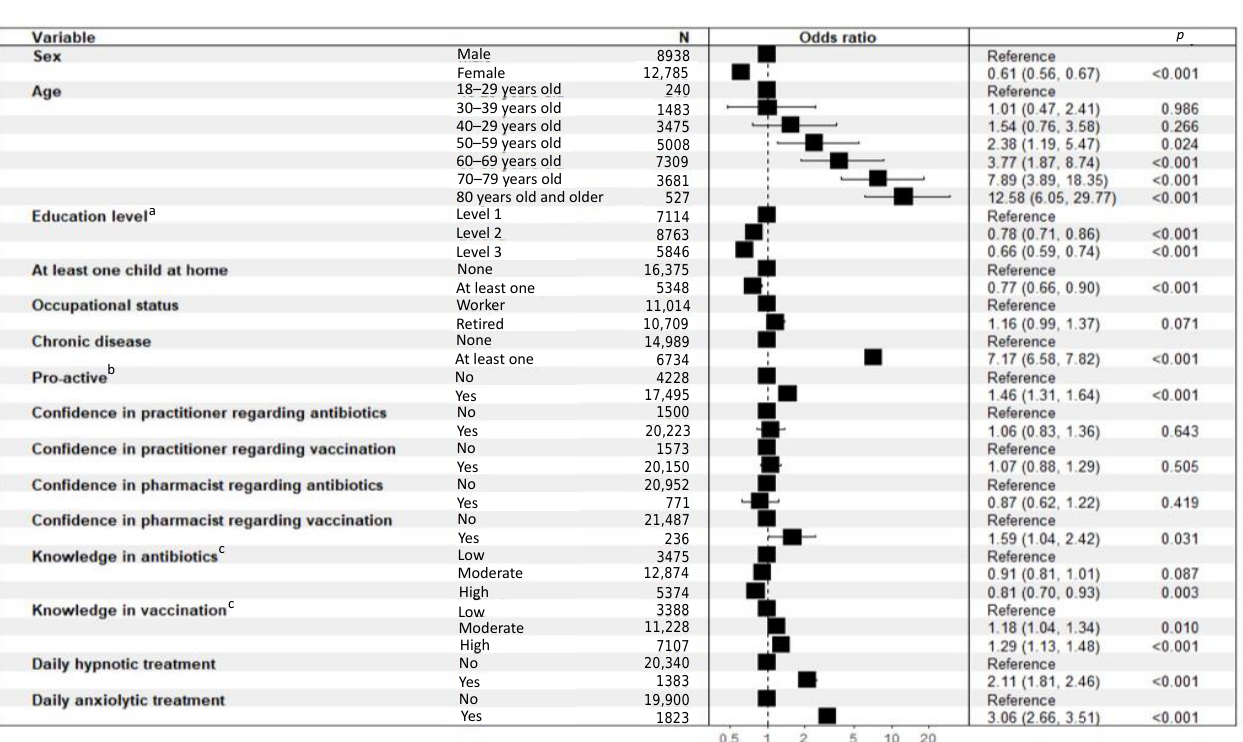
Figure 3. Binary logistic regressions performed to evaluate the determinants of polymedication. a Level 1: Level of education below “Baccalaureate” (French high school diploma) degree, Level 2: Level of education greater than or equal to “Baccalaureate” degree and less than or equal to “Baccalaureate” degree plus 2 years, Level 3: Level of study higher than “Baccalaureate” degree plus 2 years; b Proactive: ((asks physician for antibiotics) OR (if taking meds, has already discussed it with physician/pharmacist on own initiative) OR (if med for better sleep, has already tried non-medication methods) OR (if medication for anxiety, has already tried non-medication methods)), c Low: 0 or 1 right answer, Moderate: 2 or 3 right answers, High: 4 right answers.